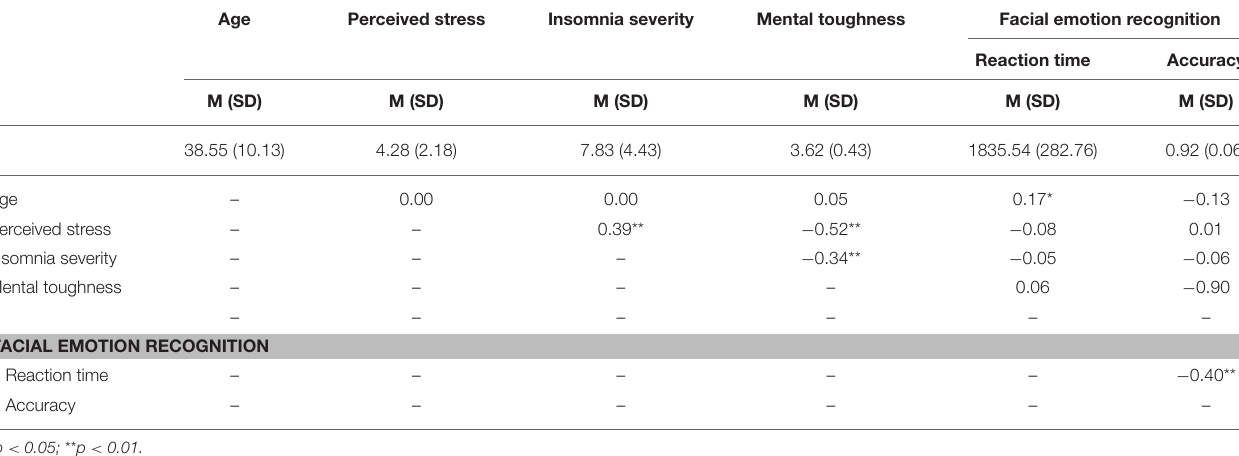
TABLE 1 | Descriptive statistical indices and correlation coefficients between dimensions of facial emotion recognition and psychological dimensions.